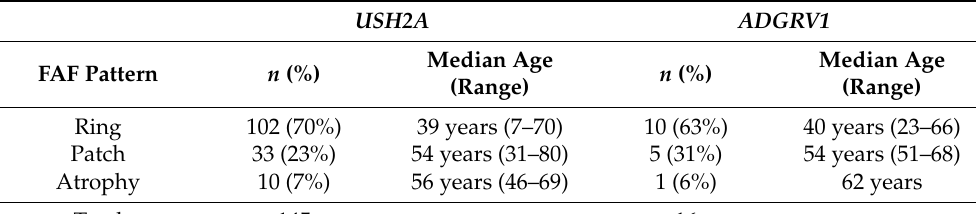
Table 2. Distribution of different FAF patterns in USH2A and ADGRV1 patient groups.